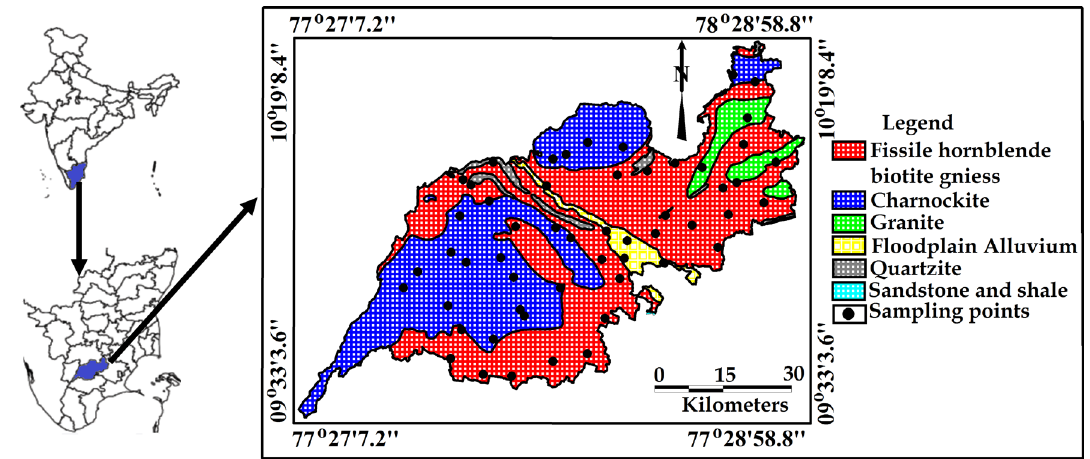
Fig. 1 Lithology and sample location points in the study